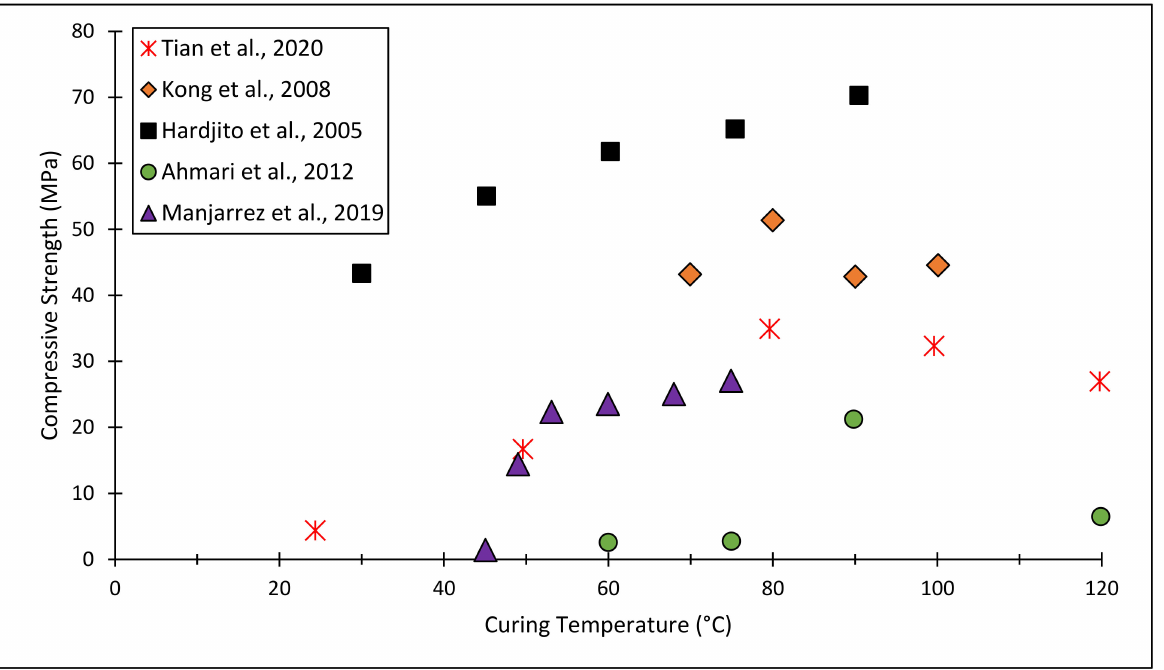
Figure 3. Graph compiling compressive strength vs. curing temperature data obtained from previous investigations